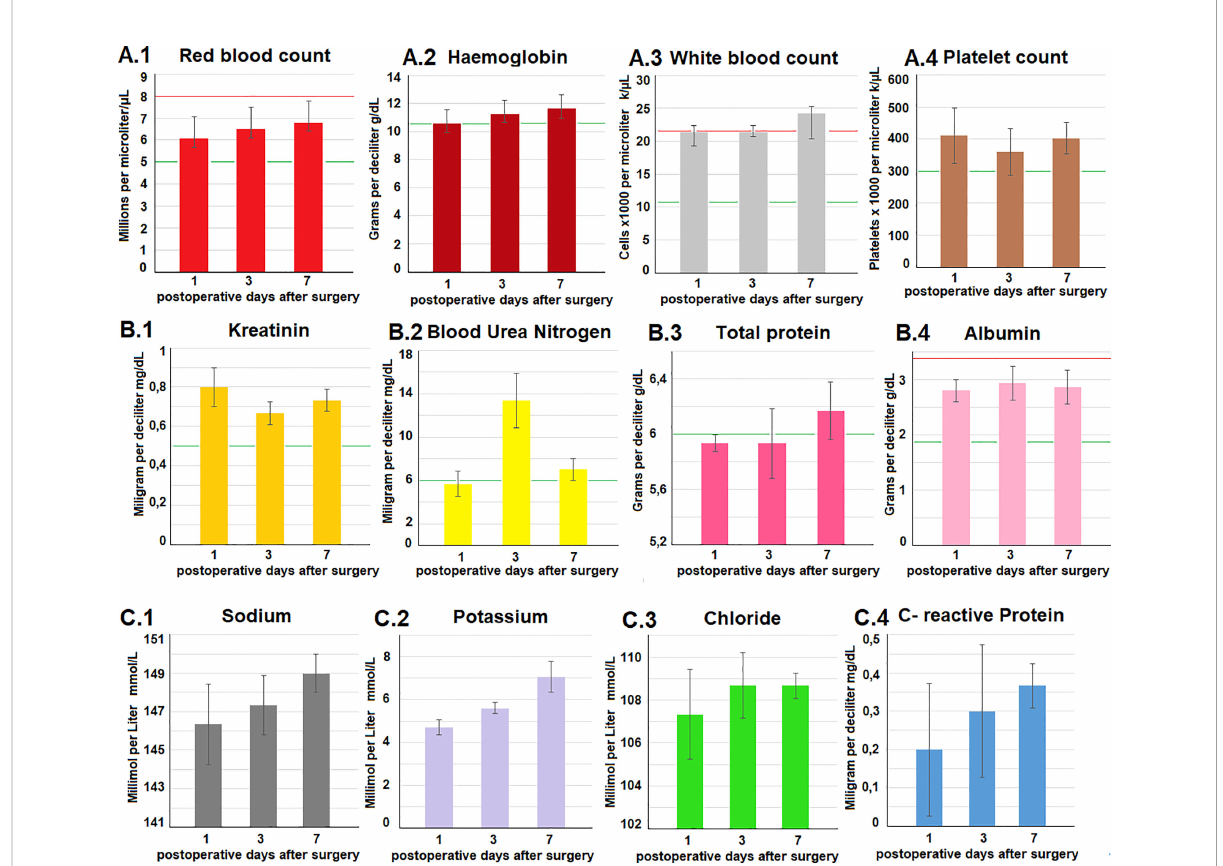
FIGURE 4 (A – C) Blood work-up on postoperative days 1, 3 and 7. Testing included a wide range of parameters. The red (upper) and green lines (lower) in each diagramm demonstrate physiological reference values of the analyzed